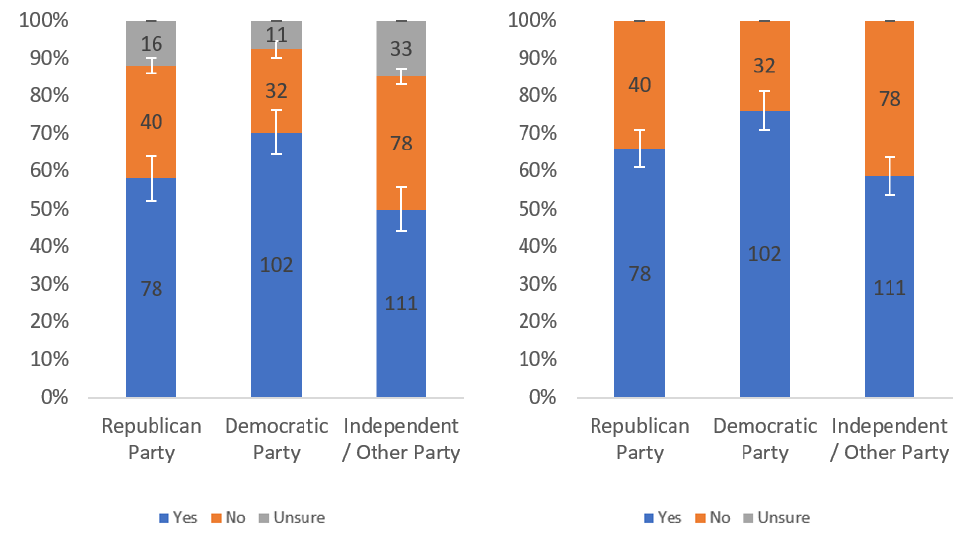
Figure 56. Responses regarding label helpfulness by party affiliation including ( left ) and excluding ( right ) unsure responses.